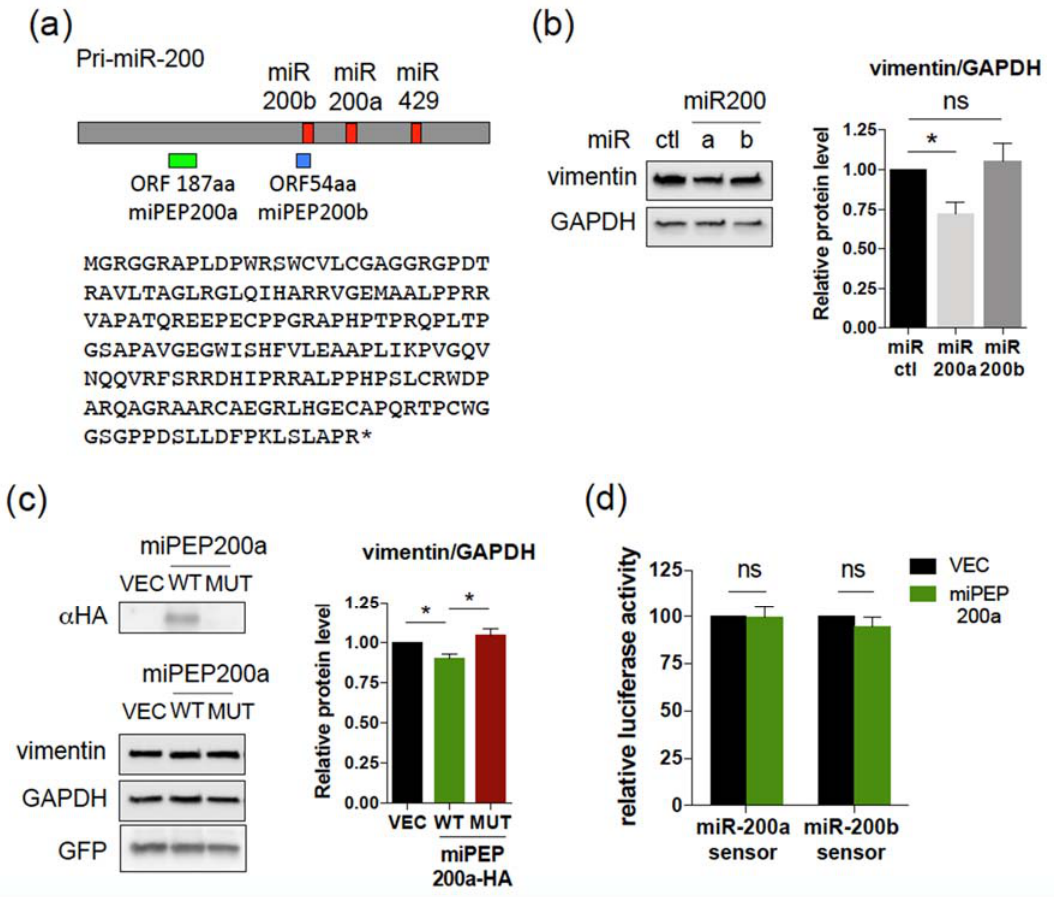
Figure 5. miPEP200a does not regulate the activities of miR-200a and miR-200b. ( a ) Schematic structure of human pri-miR- 200 with the miRNAs (red boxes), the 54 amino acid sORF (miPEP200b, blue box), the 187 amino acid sORF (green box), and miPEP200a sequence indicated. ( b , c ) Western blot analysis of PC3 cells transfected with control miRNA or miR-200a or miR-200b (10 nM) (b) or control vector or vectors expressing HA-tagged WT or mutated miPEP200a. ( c ) The vectors contain the EGFP gene, used as control of transfection efficiency. GAPDH was used as loading control. Quantifications of the immunoblots are presented in the right panels. Data are means ± S.E.M. of four ( b ) and seven ( c ) independent experiments. ( d ) Endogenous miR-200a and miR-200b activities upon overexpression of miPEP200a into PC3 cells determined by dual luciferase assays 48 h post-transfection. The relative luciferase activities of miPEP200a transfected cells were compared to that of vector transfected cells, set to 100. Data are means ± S.E.M. of four independent experiments. * p < 0.05.